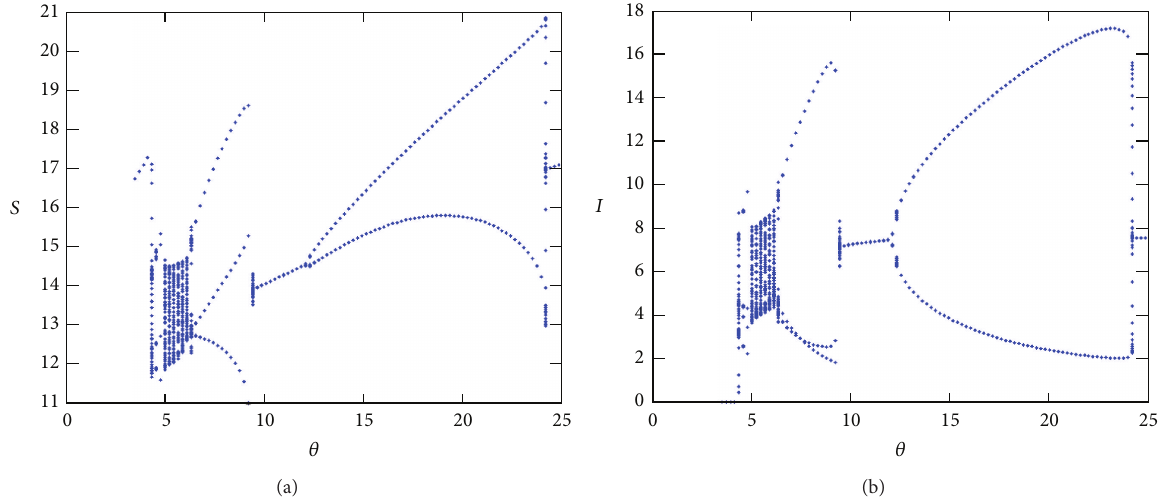
Figure 4: Bifurcation diagrams of system (8) with respect to 𝜃 in case (2) of Section